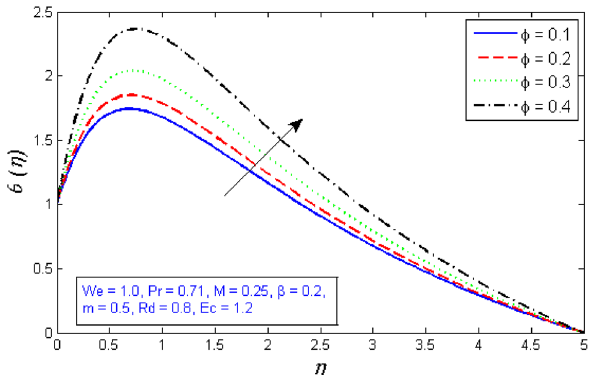
Figure 16. Represents variation of temperature distribution for several number of volume fraction φ .